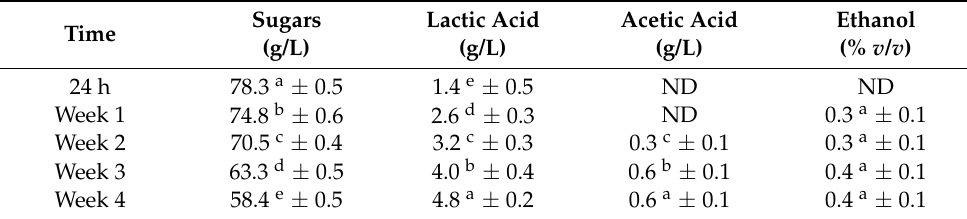
Table 1. Analysis of sugars, organic acids, and ethanol in pomegranate juices fermented by L. paracasei SP3 after fermentation (24 h at 30 ◦ C) and during 4 weeks of storage at 4 ◦ C. Sugars Lactic Acid Acetic Acid Ethanol Time (g/L) (g/L) (g/L) (% v/v ) 24